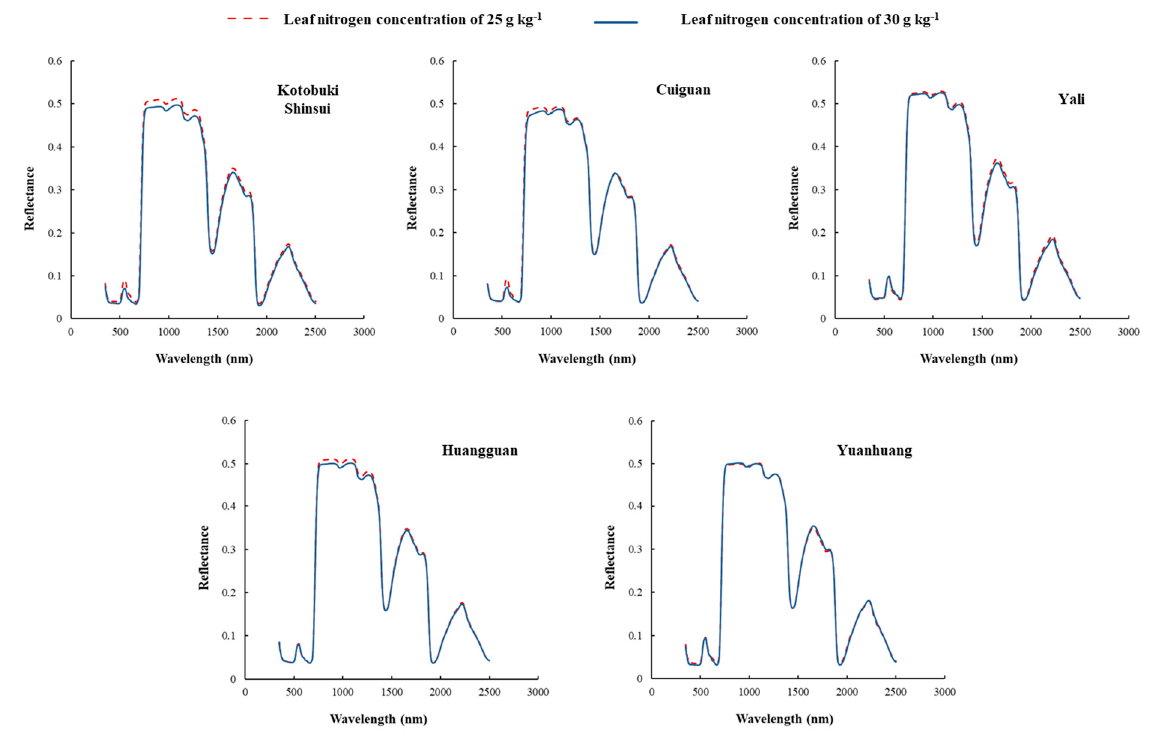
Figure 1. Leaf spectra of five cultivars with two different leaf nitrogen concentrations (25 g kg − 1 and 30 g kg − 1 ). The spectra in visible and near infrared regions of Kotobuki Shinsui and Cuiguan differed with different leaf nitrogen concentrations. In addition, the spectra in near infrared regions of Huangguan differed with different leaf nitrogen concentrations. However, the leaf spectra in all regions of Yali and Yuanhuang were not apparently differed from different leaf nitrogen concentrations.